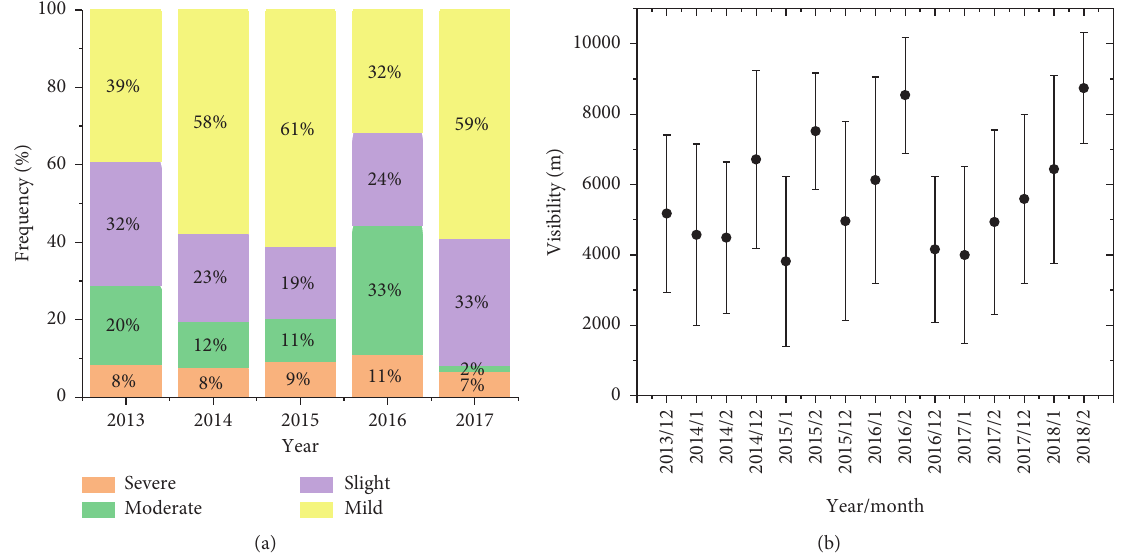
Figure 2: Frequency of different intensity levels of haze days (a) and the monthly mean winter visibility (b) between 2013 and 2017 in Xinjin Airport. Table 1: Visibility, relative humidity, and PM